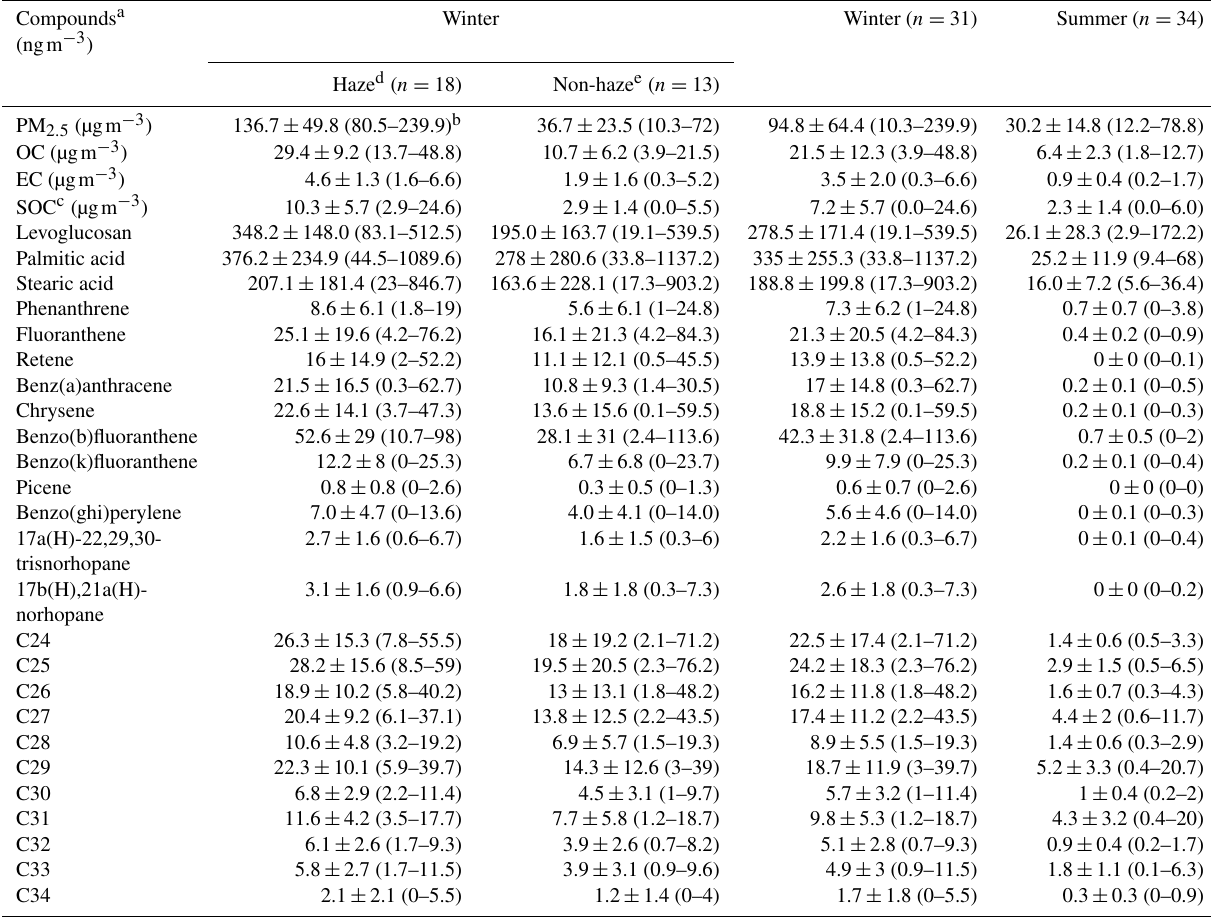
Table 1. Summary of measured concentrations at IAP site in winter and summer.